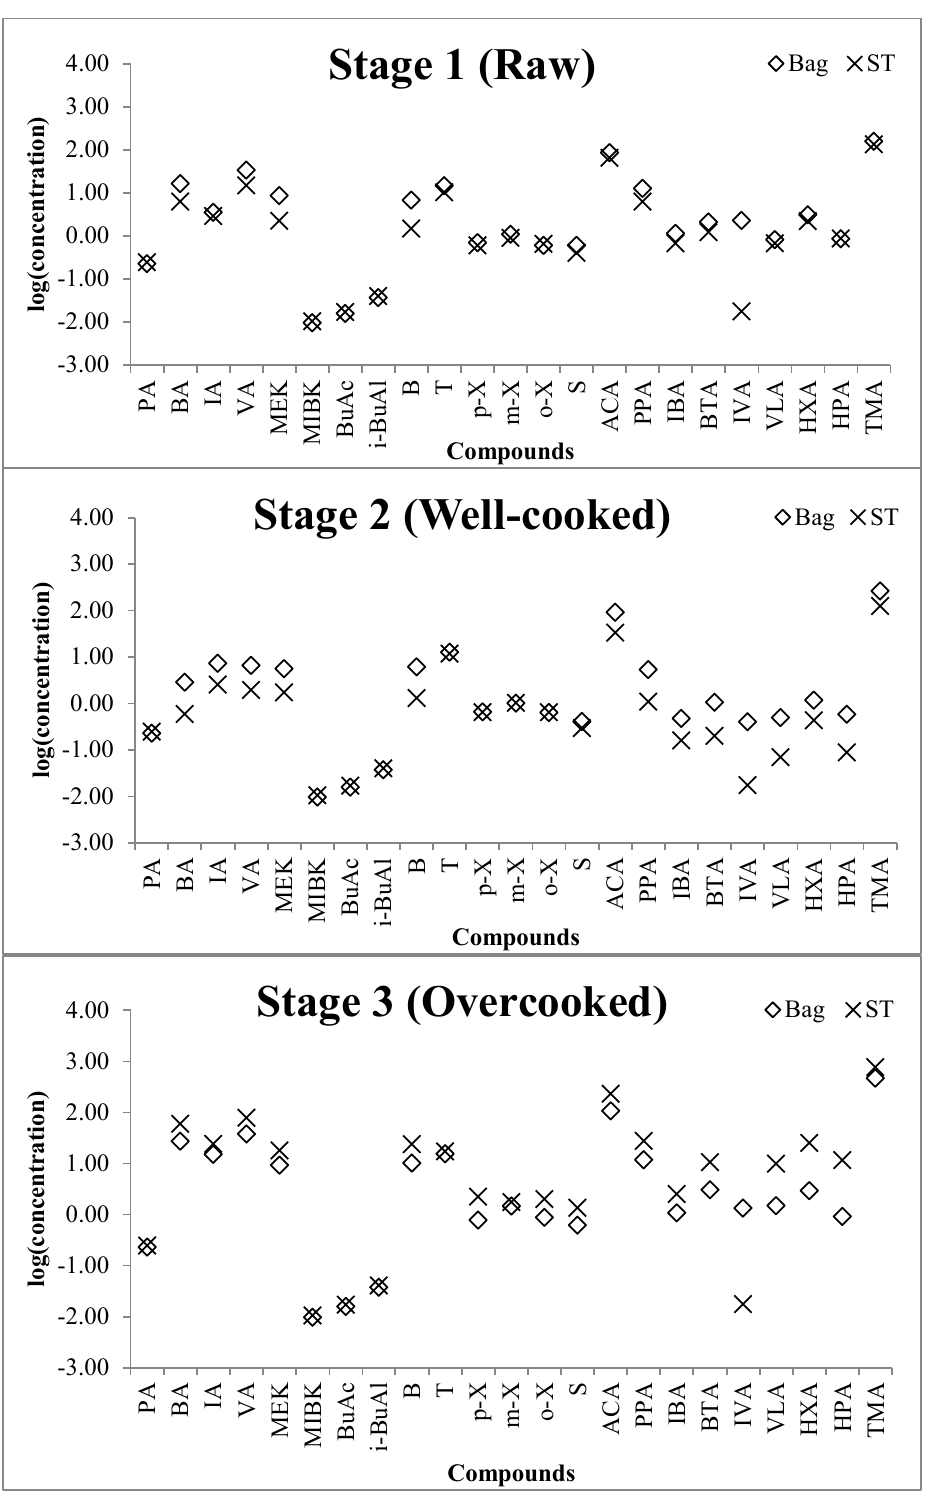
Figure 3. Comparison of concentration (ppb) of all compounds between three different cooking